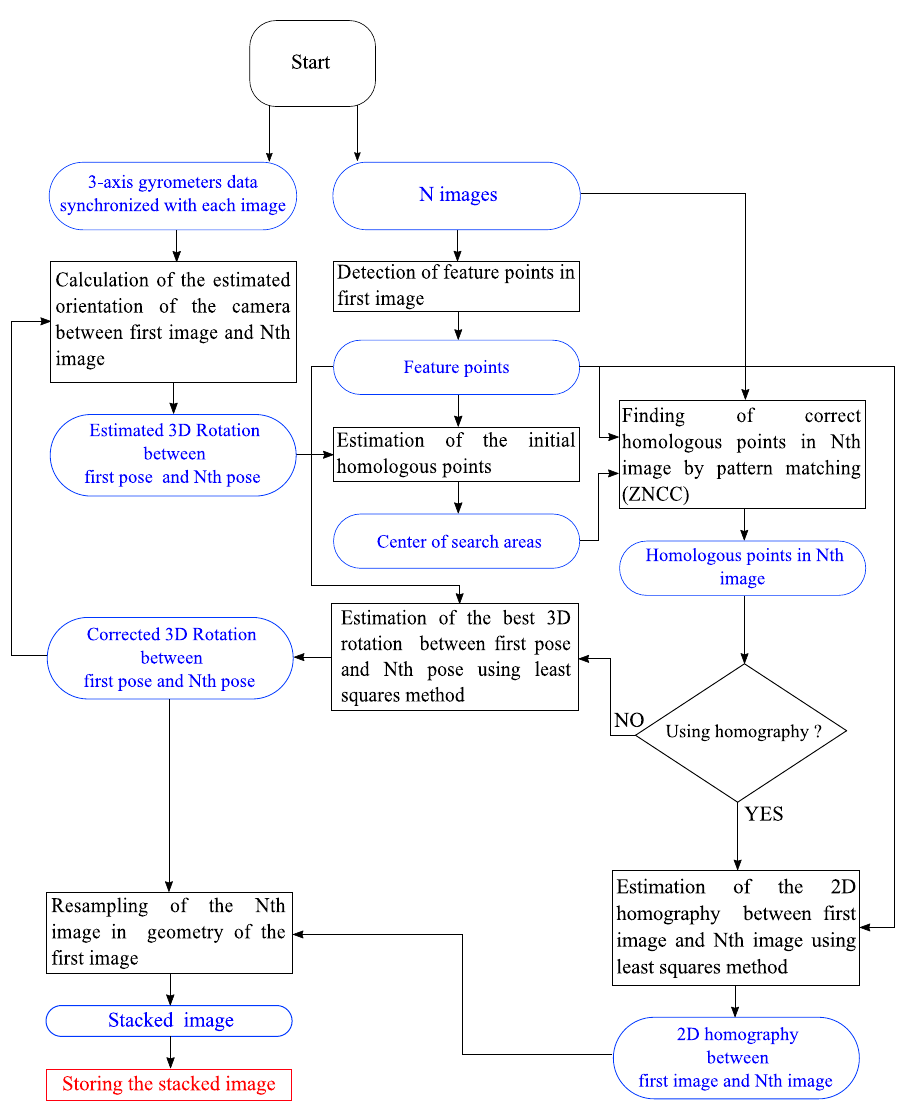
Figure 4. Architecture of the